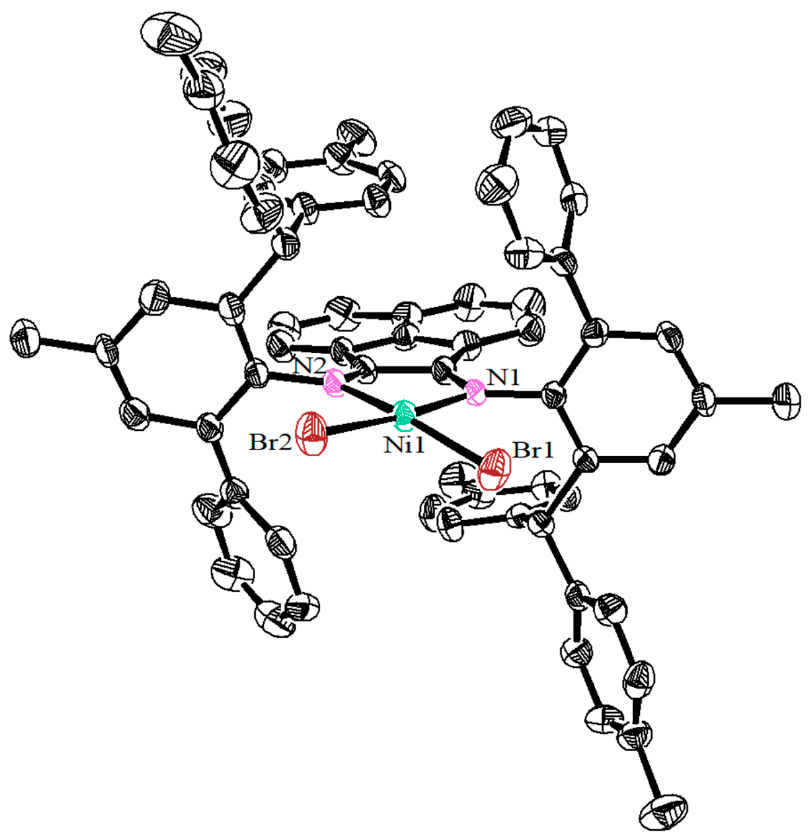
Figure 1. Single crystal structure of Ni2 (2233726) presented by ORETP (Oak Ridge Thermal Ellipsoid Plot) with 30% probability level, and H atoms were omitted for